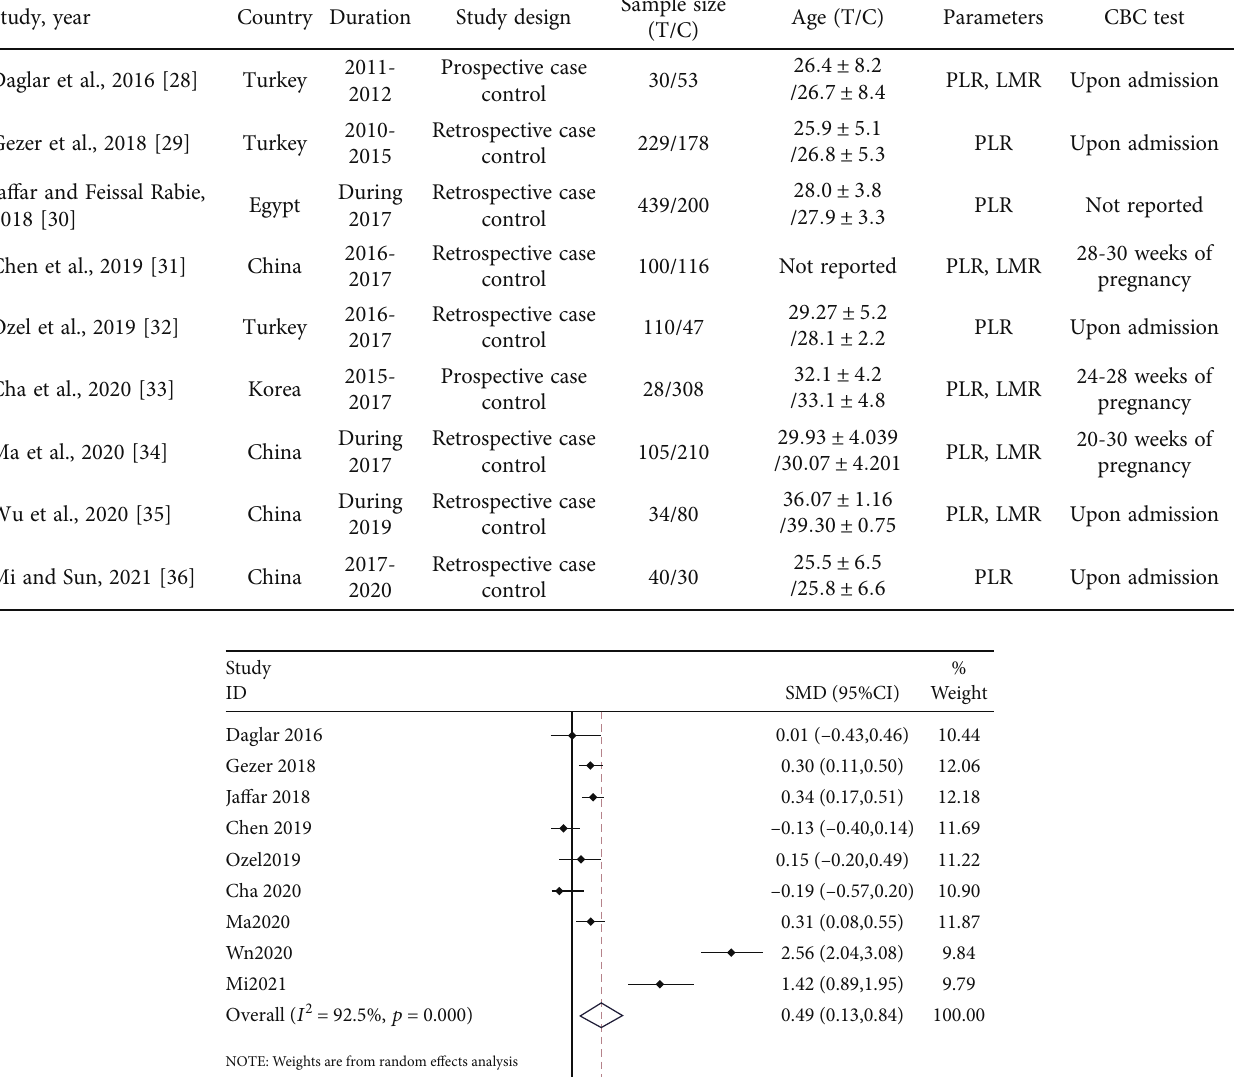
Table 1: The included studies and their attributes.